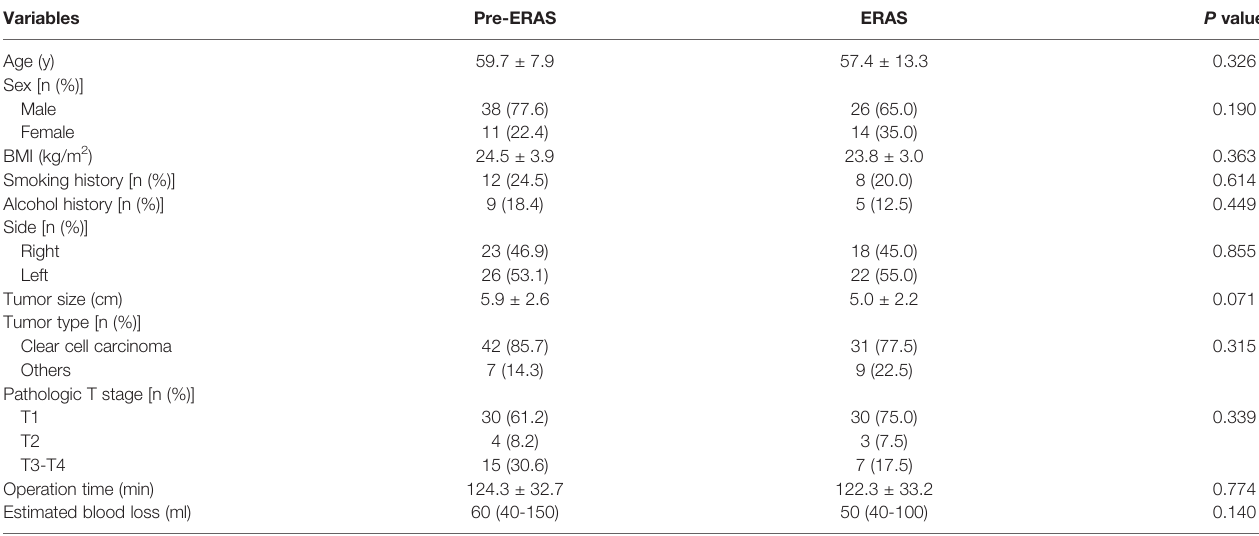
TABLE 2 | Summary of the clinical and surgical details of the patients.